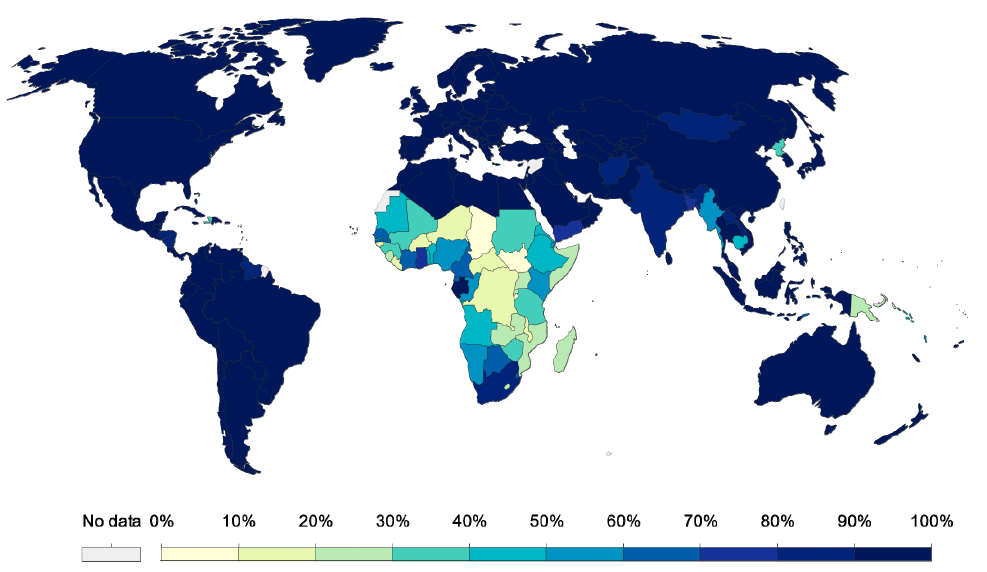
Figure 7. Share of the population with access to electricity [19].